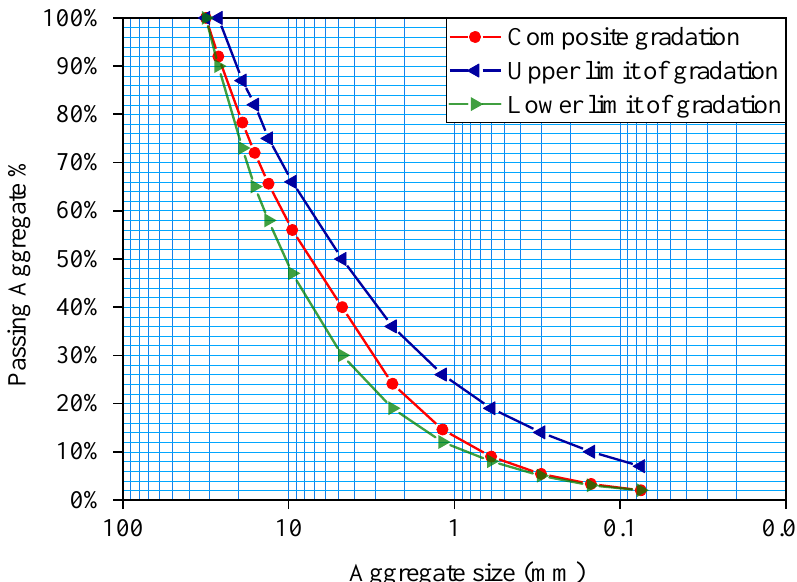
Figure 13. Grading curve of coal gangue. Table 10. Crushed stone particle grading.